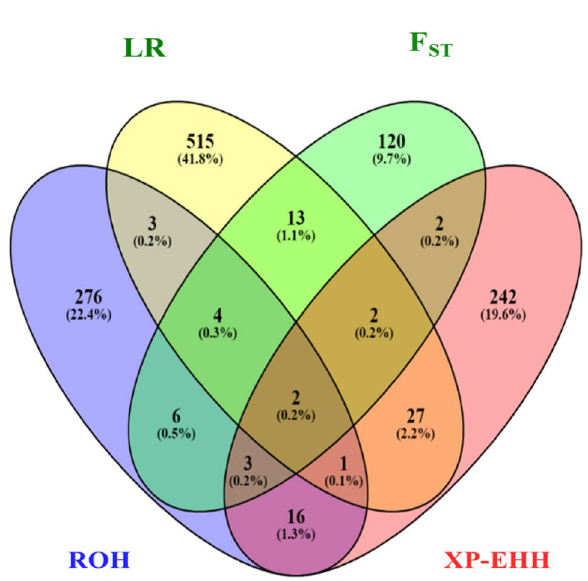
Figure 5. Venn diagram showing the number of genes that were specific and common to the four selection signature methods performed in this